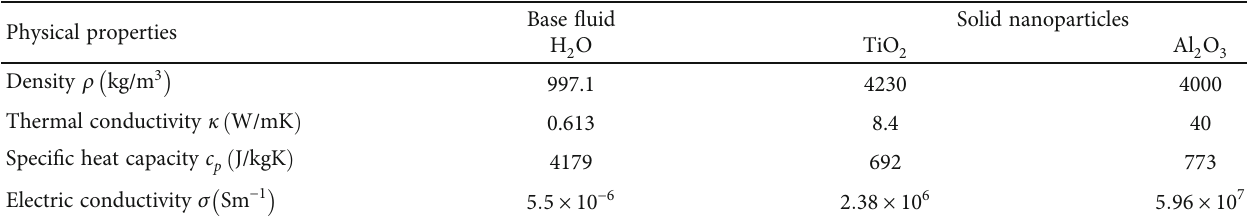
Figure 22: Impact of local inertia parameter Fr and couple stress parameter K on skin friction g ′ ð 0 Þ . Table 1: Thermophysical properties of H O , titanium oxide, and aluminum 2